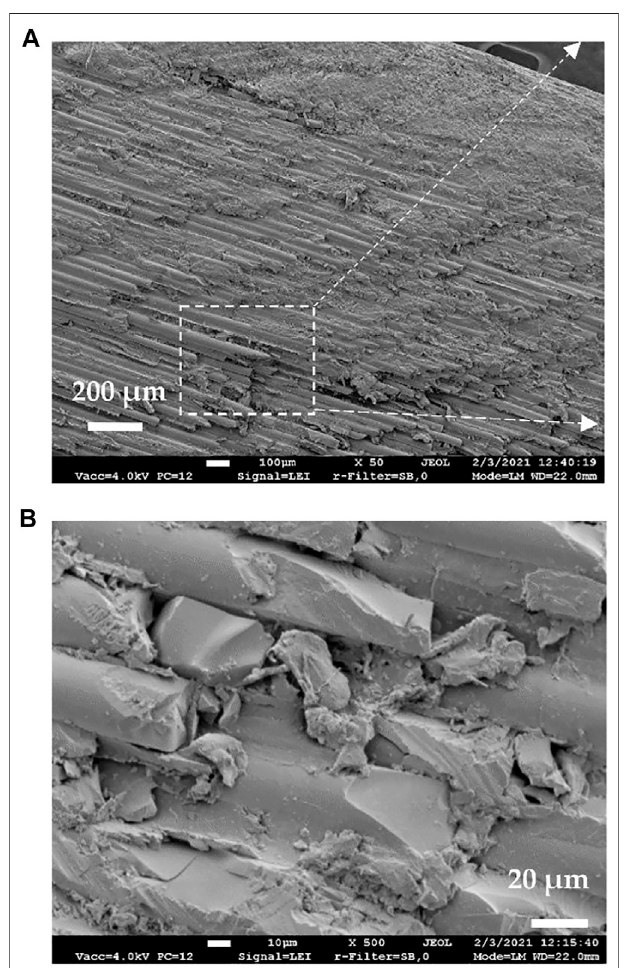
FIGURE18| Amicrostructurecorrespondingtothetensioncouponcut- side surface consistent with the pultrusion direction: (A) × 50 and (B) × 500 magni fi cations. Note: the rectangle localizes the zoomed view place of the image (B) .